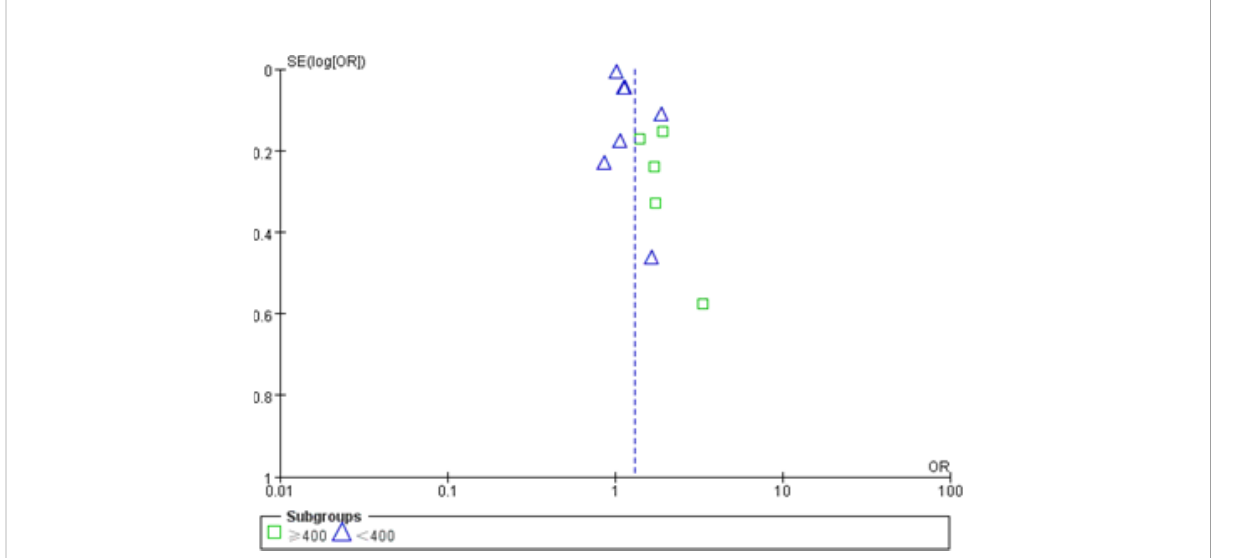
FIGURE 8 Funnel plot of publication bias of NLR with poor outcome.